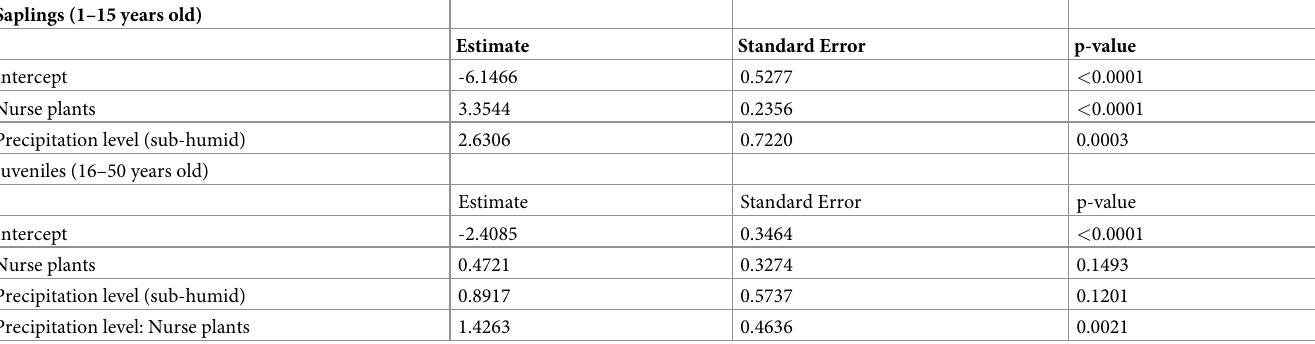
Table 2. Model summaries of best logistic model (GLMM) for the association of recruits of Quercus ilex to nurse plants.